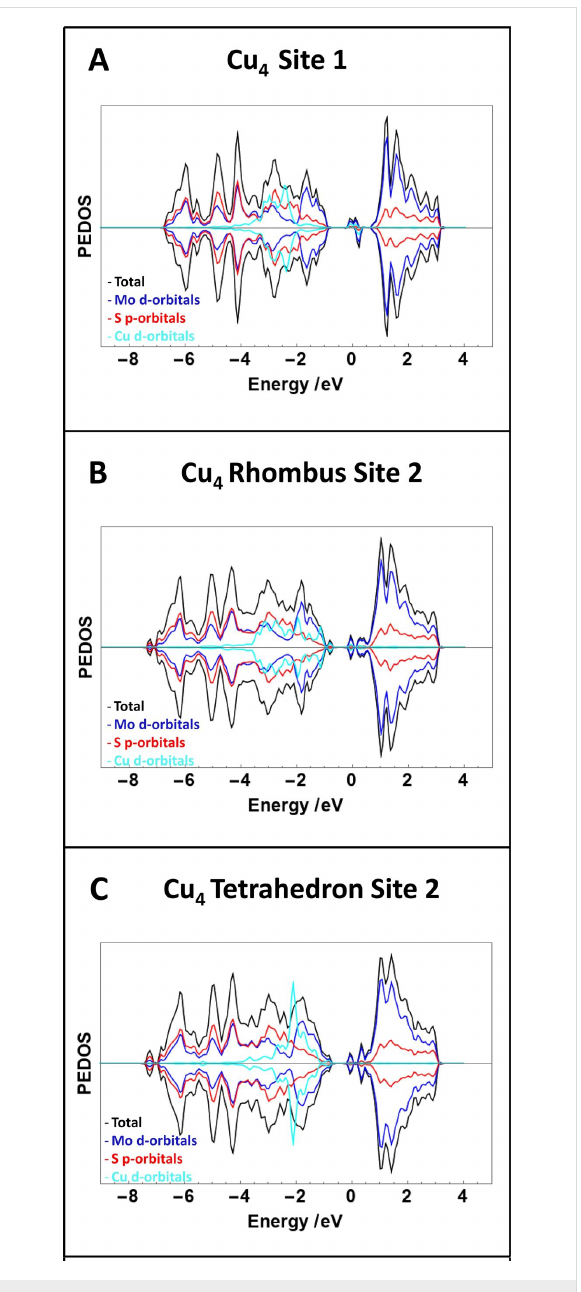
Figure 7: DOS plots of most favourable Cu 1 and Cu 4 adsorption struc- tures on defective MoS 2 . The contribution of the Cu d orbitals has been increased by a factor of five for the ease of comparison and zero on the “energy” scale is the Fermi level.